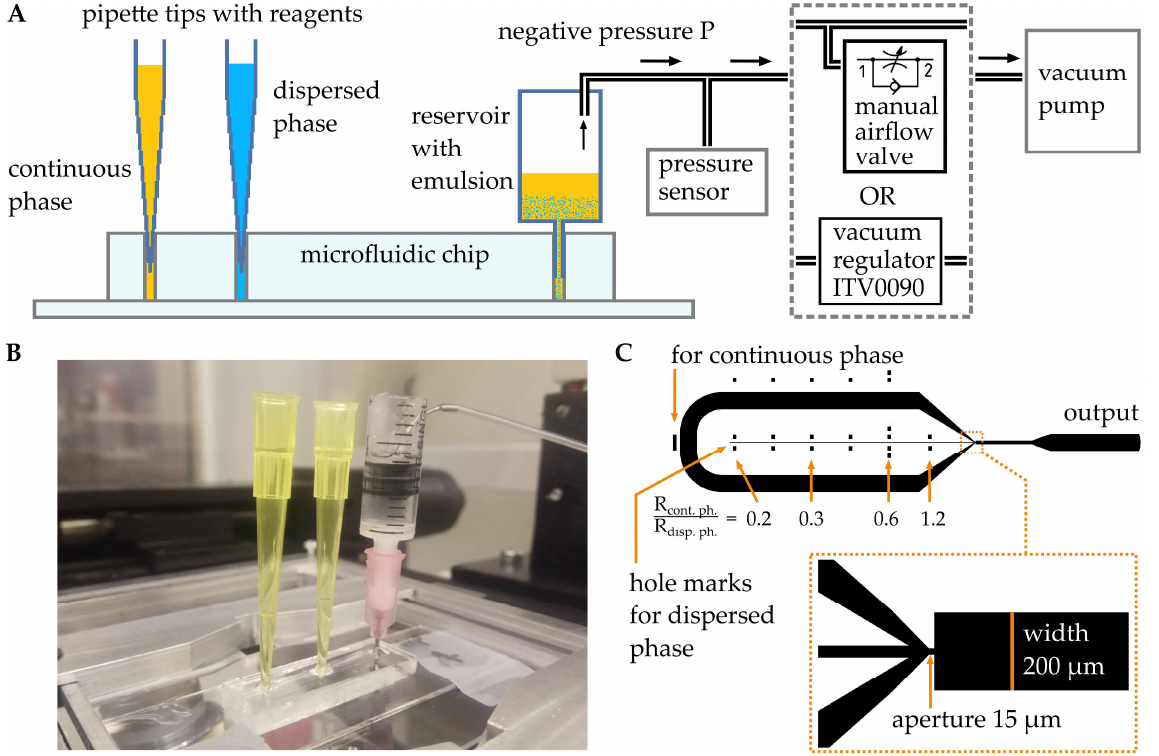
Figure 1. Droplet generation in a flow-focusing microfluidic device by applying negative pressure to the output reservoir: ( A ) circuit diagram of the setup; ( B ) general view of the microfluidic device; ( C ) design of the microfluidic chip.